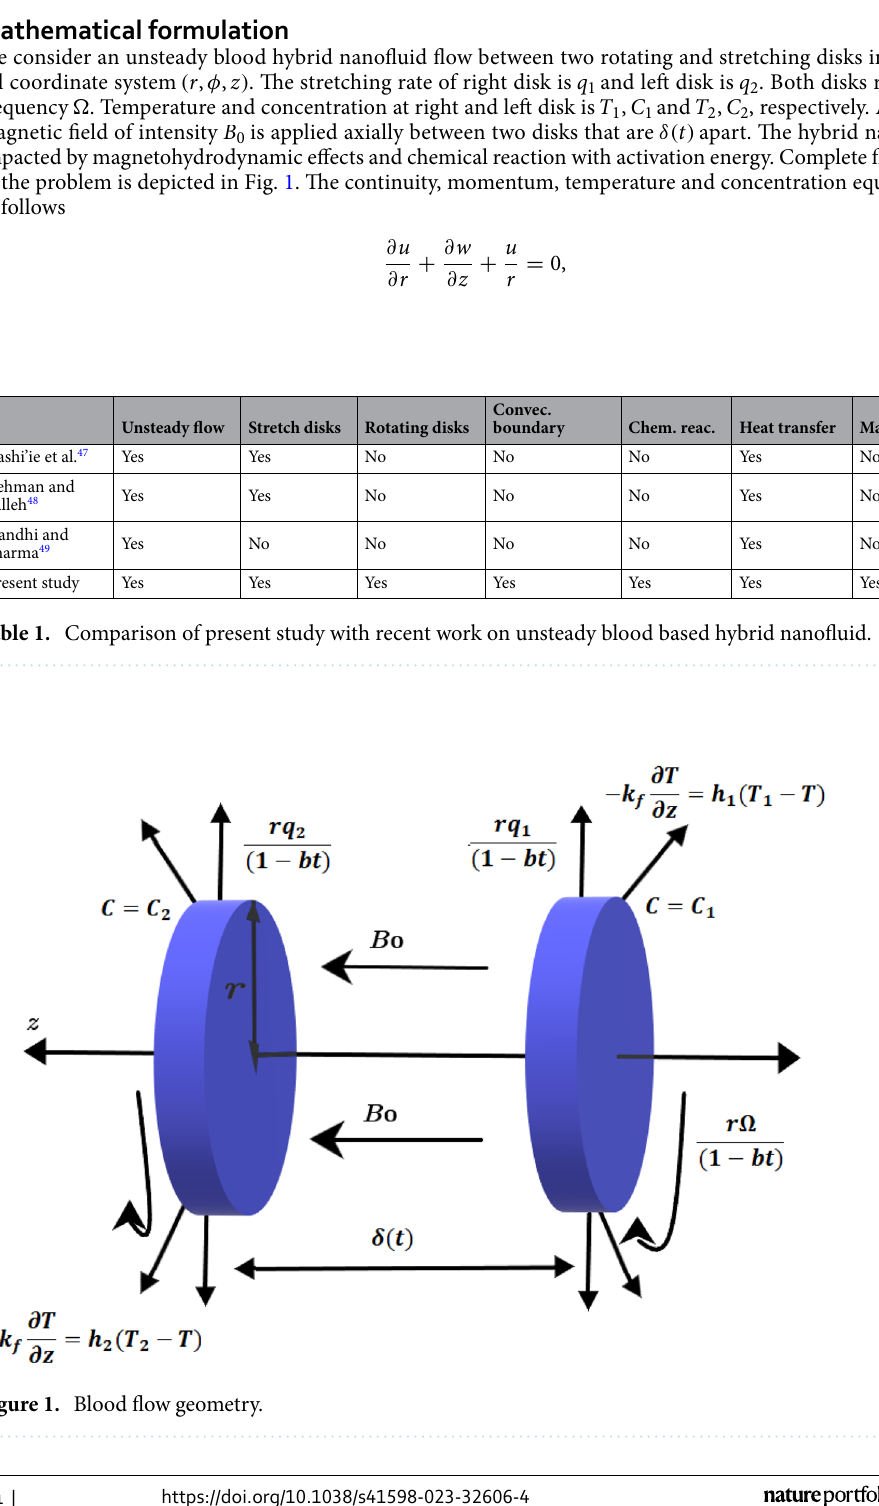
Figure 1. Blood flow